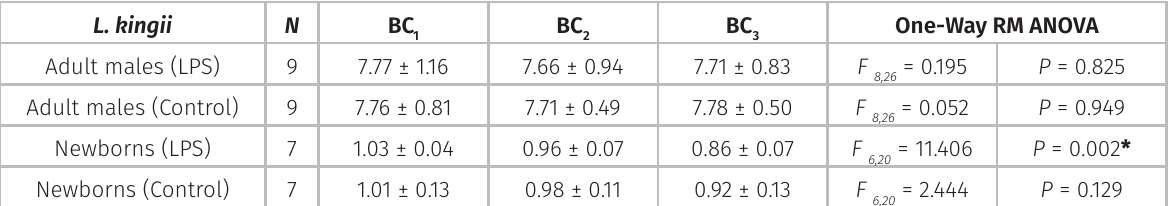
) of the immune challenge, are presented and 3